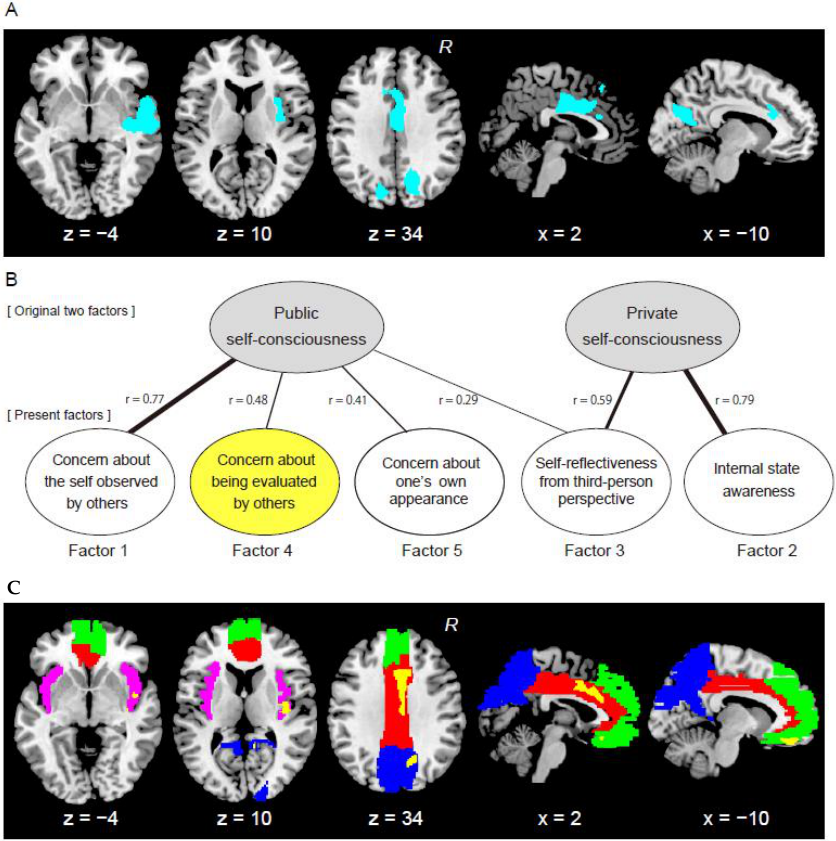
Figure 1. Summary of the factor analysis and voxel-based morphometry (VBM) analysis results. ( A ) Brain regions (cyan) in which gray-matter volume was positively correlated with public Self-Consciousness Scale (SCS) score. Images were superimposed onto the transvers and sagittal sections (z = − 4, 10, and 34; x = 2 and − 10) of a Montreal Neurological Institute (MNI) standard brain. We used a height threshold of p < 0.005 and an extent threshold of p < 0.05 family-wise error rate (FWE) corrected within the whole brain. ( B ) The five factors identified in the present study and their relationships with the original two (public and private) factors of self-consciousness. The thickness of the lines indicates correlation coefficients between the factor score for each of the five factors and the public or private SCS score ( r , see details in the text). ( C ) Brain regions (yellow) in which gray-matter volume was positively correlated with the score of Factor 4, which was a subfactor of public self-consciousness, within four regions of interest (ROIs) (Insula ROI: magenta, anterior cingulate cortex/middle cingulate cortex (ACC/MCC) ROI: red, precuneus/cuneus ROI: blue, medial prefrontal cortex (MPFC) ROI: green). Images were superimposed onto the transverse and sagittal sections (z = − 4, 10, and 34; x = 2 and − 10) of an MNI standard brain. We used a height threshold of p < 0.005 (uncorrected) and an extent threshold of p < 0.05 corrected in each ROI (small volume correction). Abbreviations: R, right